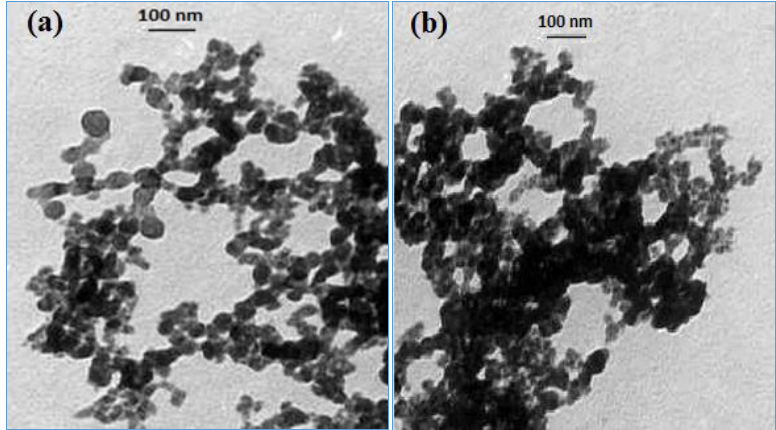
Fig. 6. TEM image of (a) bare magnetite nanoparticles, (b) ascorbic acid coated magnetic Fig. 6